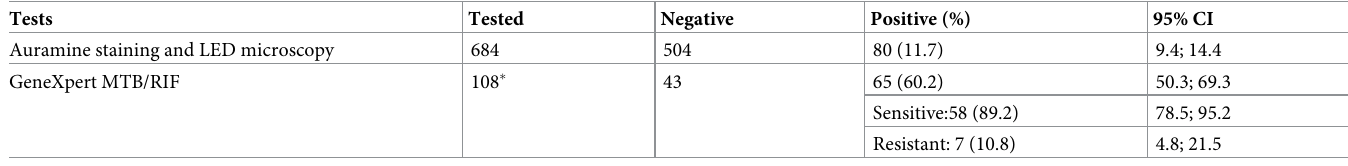
Table 1. Results of different tests for the diagnosis of human tuberculosis (n = 684) in selected districts of Bangladesh, 2018. Tests Auramine staining and LED